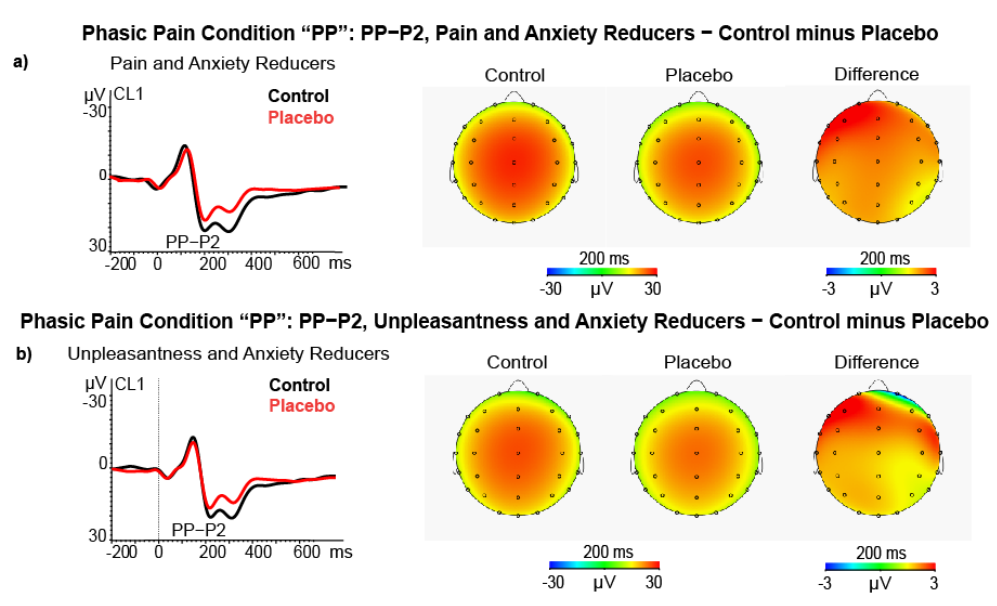
Figure 6. ( a ) ERP, Scalp maps and difference maps of PP − P2 amplitude in high pain and state anxiety reducers ( N = 15); ( b ) ERP, Scalp maps and difference maps of PP − P2 amplitude in high pain and state unpleasantness reducers ( N = 15).